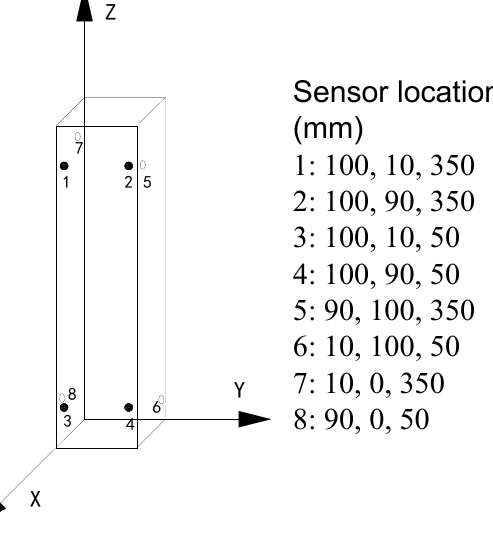
Figure 3. Sensor location in the reinforced concrete.